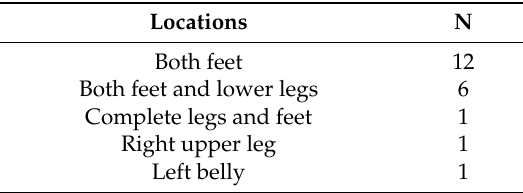
Table 2. Location of neuropathic pain.